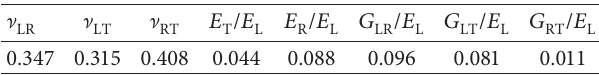
Figure 2: Compression curves of confined compression tests of wood cylinders parallel to the grain. Table 2: Elastic ratio and Poisson’s ratio of